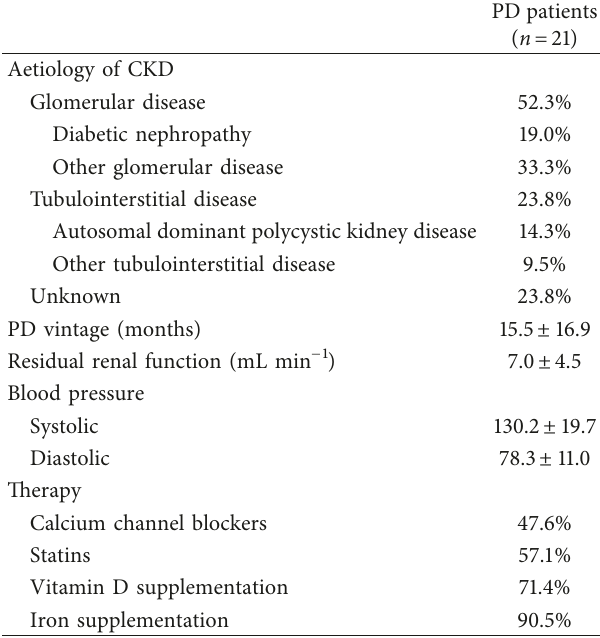
Table 2: Aetiology of chronic kidney disease (CKD), time on peritoneal dialysis, residual renal function, and blood pressure of peritoneal dialysis (PD) patients.